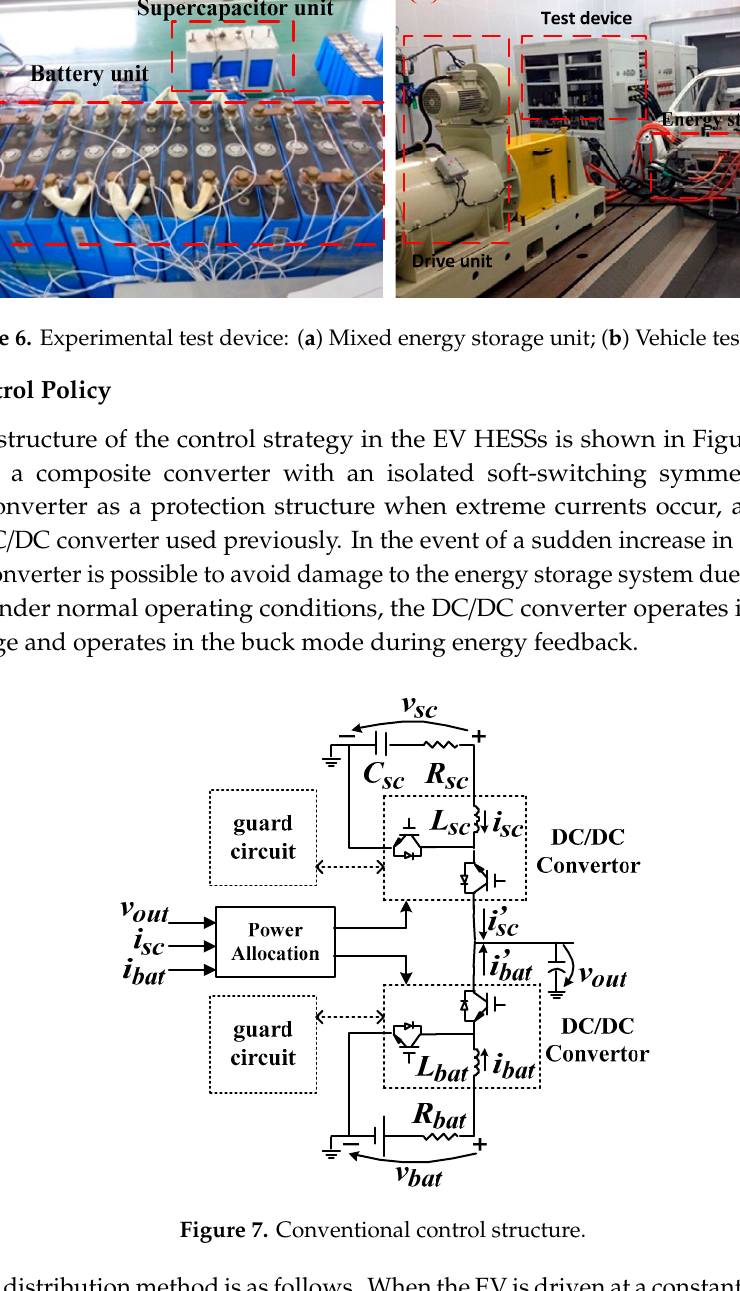
Figure 8. 1015 driving cycle.